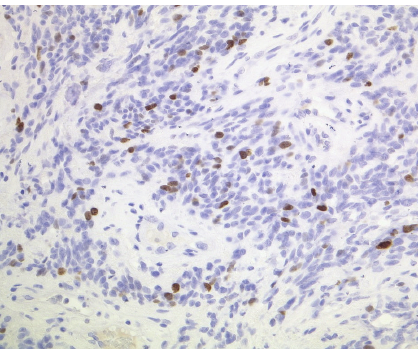
Figure 6: Ki67-index was increased, with up to 30% positive nuclei (anti-Ki67, ABC, × 200, original magnification).